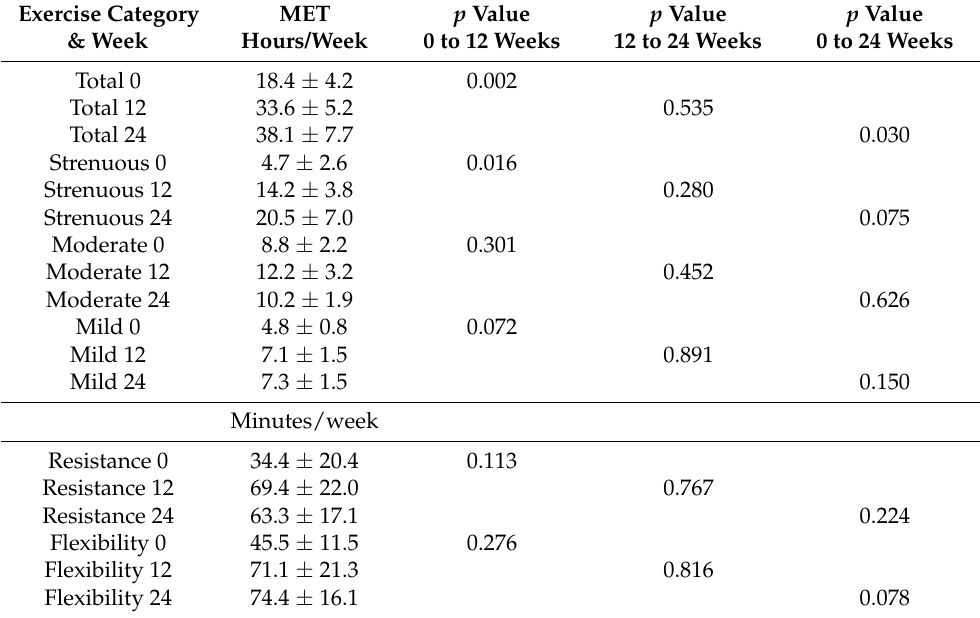
Table 5. Godin’s Leisure Time Exercise